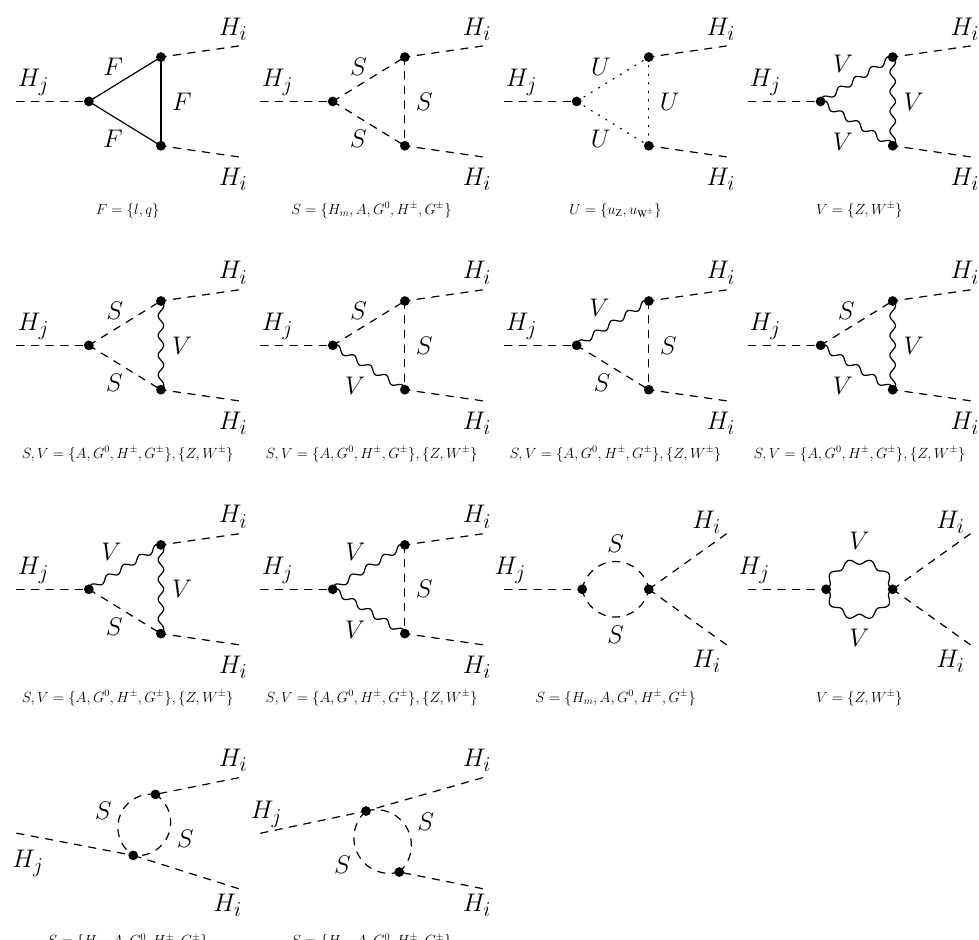
Figure 11 . Generic diagrams contributing to the vertex corrections in H j ! H i H i